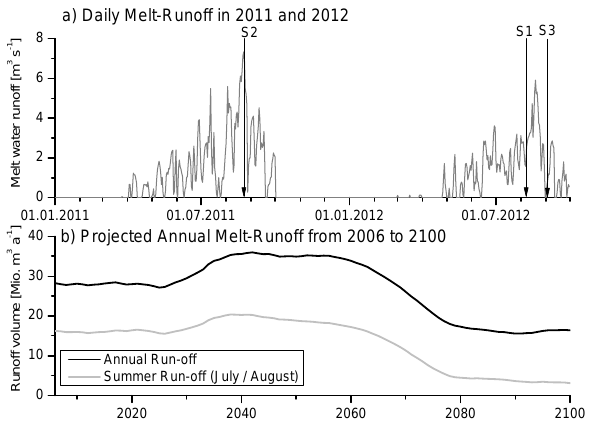
Fig. 9. (a) Calculated meltwater runoff from the surface of the Plaine Morte in 2011 and 2012. The three dates of the tracer in- jections are illustrated in the figure with an arrow labeled with the according situation. (b) 20yr running means (annual runoff and the summer runoff) of projected future runoff volume from the basin of the Plaine Morte driven with a median climate change scenario.